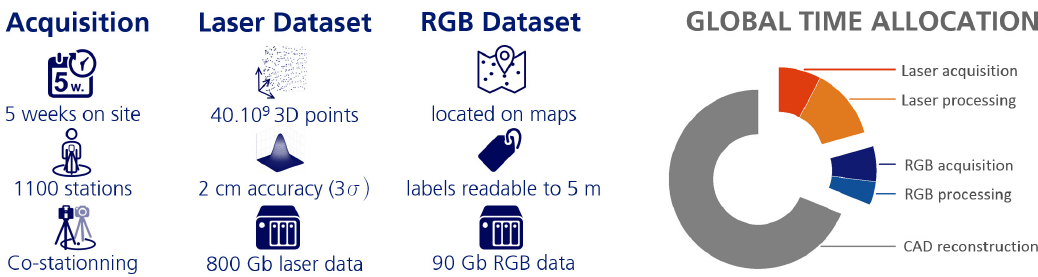
Figure 6. Key numbers in the multi-sensor scanning survey of a nuclear reactor building [1]; the main order of magnitude that may be highlighted is the number of stations: more than 1000 stations (for more details, see [35]). The relative time allocation is shown on the graph; CAD reconstruction is the main budget.